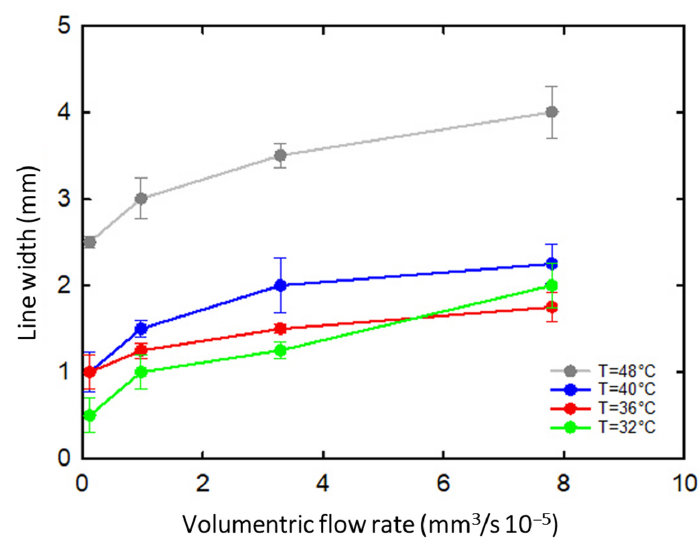
Figure 5. The printed filament diameter as a function of the volumetric flow rate at different extrusion temperatures; lines are intended to guide the